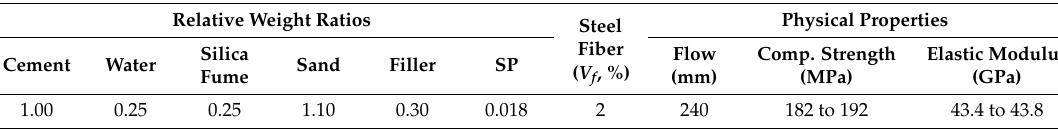
Table 1. Mix proportion and physical properties of UHSFRC.